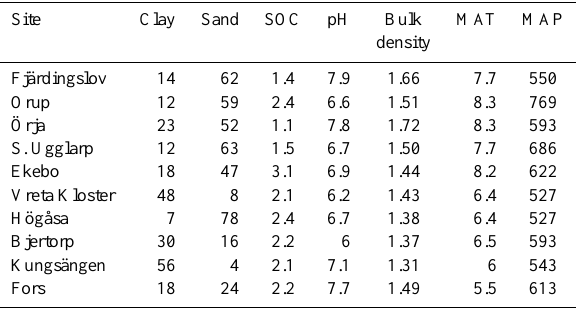
Table 2. Basic soil parameters and climate data for the 10 study sites at the beginning of the experiments: clay and sand content (%), soil organic carbon content (%), soil pH, bulk density (gcm − 3 ), mean annual temperature (MAT) ( ◦ C) and mean annual precipita- tion (MAP)